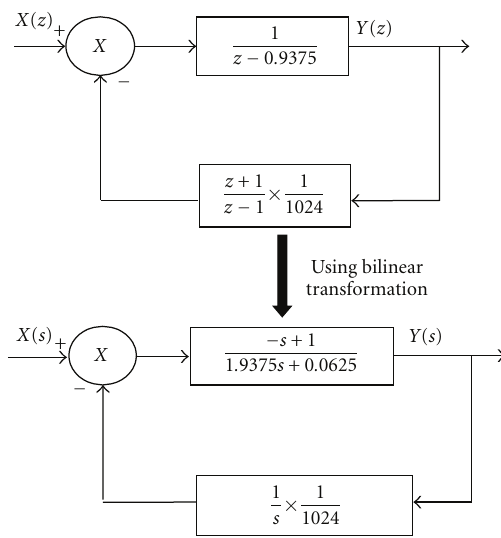
Figure 5: Block diagram of PLL system in analyzing transient